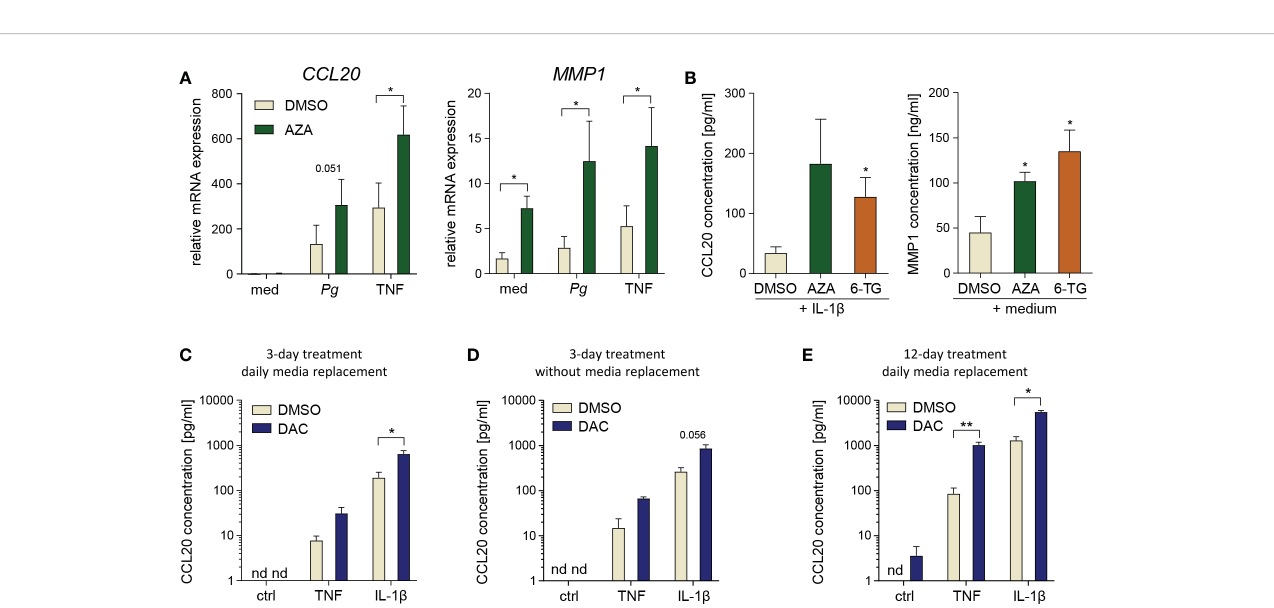
FIGURE 3 Degradation products or off-target effects are not responsible for DAC effects on GFs. (A) qPCR analysis of CCL20 and MMP1 mRNA expression in GFs treated with DMSO or 5-azacitidine (AZA) for 12 days followed by infection with P. gingivalis ( Pg , MOI 20) or stimulation with TNF (10 ng/ml) for 4 h (n=5). (B) CCL20 and MMP1 production by GFs cultured with DMSO, AZA or 6-thioguanine (6-TG) prior to 24 h culture in medium alone or stimulation with IL-1 b at 10 ng/ml h (n=5). *P < 0.05, RM One-way ANOVA followed by Bonferroni multiple comparison test. (C-E) CCL20 production by GFs (n=3- 4) stimulated with TNF or IL-1 b (both at 10 ng/ml) for 24 h after culture in the presence of DMSO or DAC: (C) for 3 days with replacement of medium and compounds every day, (D) for 3 days without replacement of medium and compounds, or (E) for 12 days with replacement of medium and compounds every day. nd, not detectable; *P < 0.05, **P <